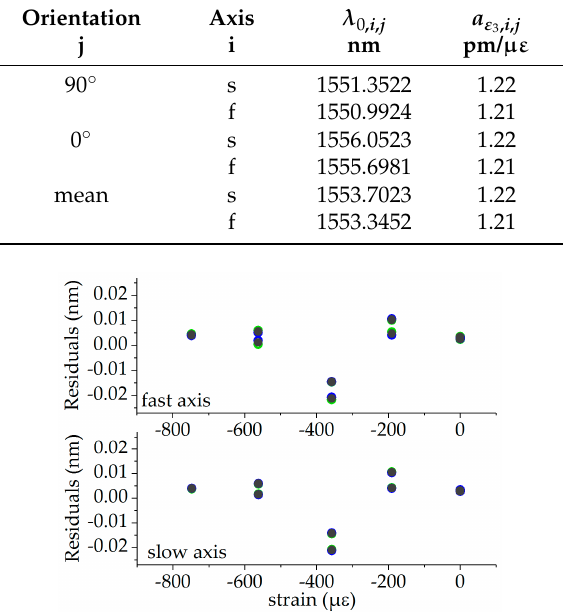
Figure 10. Strain calibration of the surface-attached PM tandem: FBG in the 0°-orientation in green, FBG in the 90°-orientation in blue, and mean values in grey.